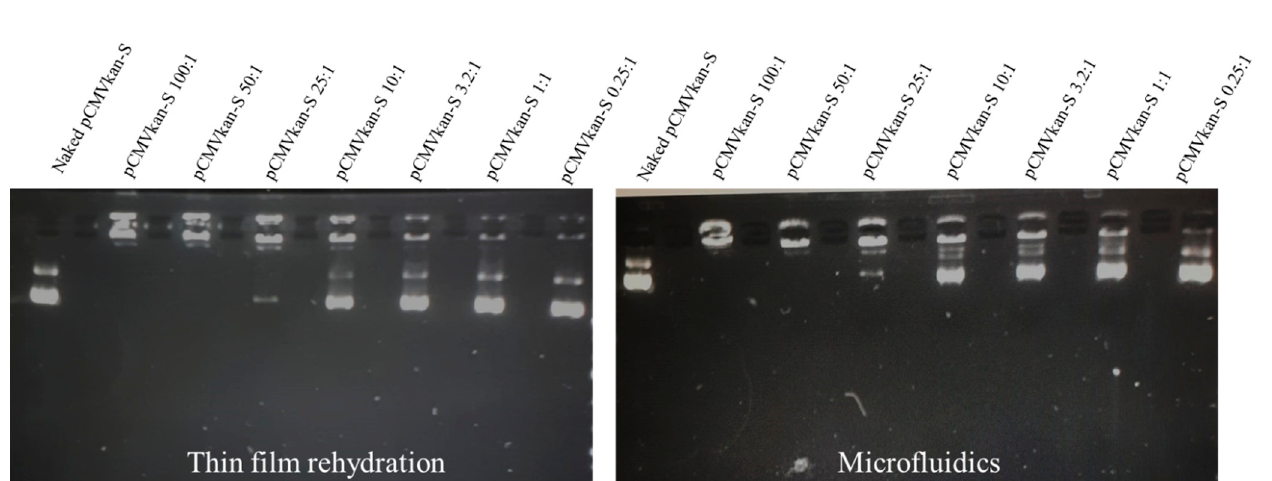
Figure 5. Zeta-potential results of DOTAP4/pCMVkan-S complexes at different N/P ratios. Graph on the left shows the results obtained with TF-manufactured liposomes. Graph on the right shows the results obtained with MF-manufactured liposomes. Data are represented as mean ± SD ( n = 3).